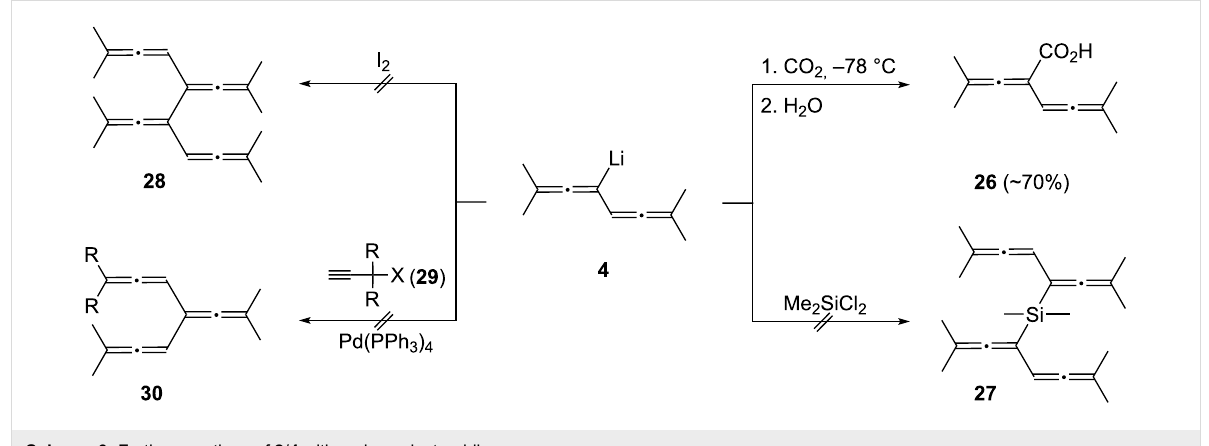
Scheme 6: Further reactions of 2 / 4 with various